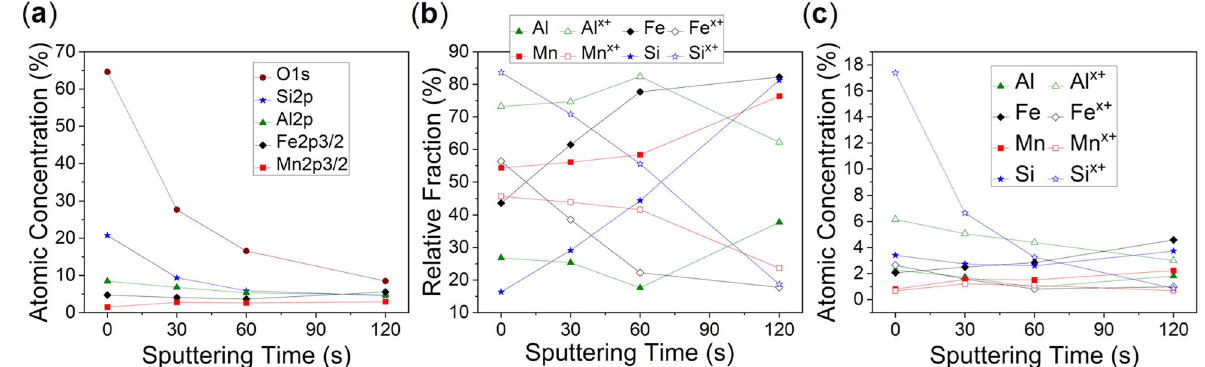
Fig. 6 XPS of the AlFeMnSi surface after potentiostatic conditioning for 1 h at − 250 mV SCE in 0.6 M NaCl. Distribution of elements as a function of sputtering time determined by XPS following potentiostatic conditioning for 1 h at − 250 mV SCE of the AlFeMnSi alloy in 0.6 M NaCl: a atomic concentration, b relative fraction of oxidized element to corresponding unoxidized metal species, and c atomic concentration of oxidized and unoxidized species.